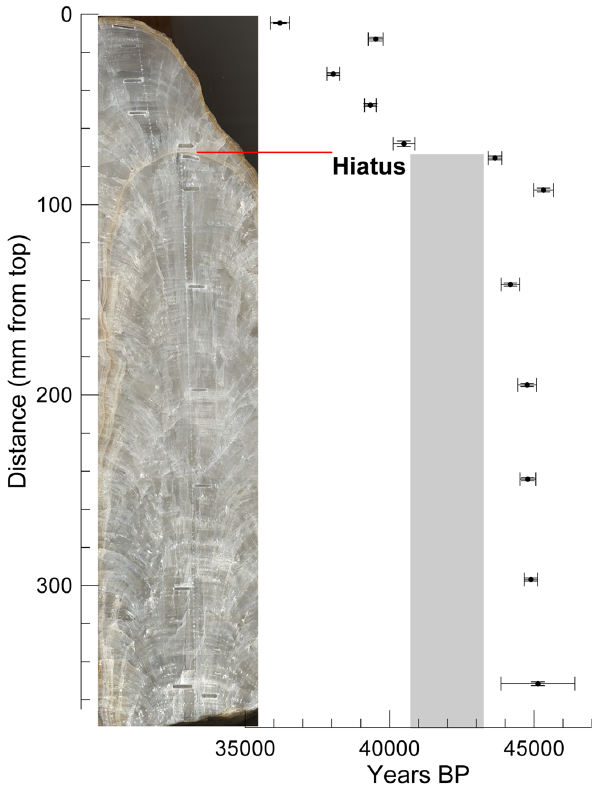
Fig. 5. Depth-age diagram of YOK-G: U-series dates included in this example are shown as red dots. Two different layer counts (vio- let and red lines) are available for the interval between 30 to 55mm from top (see zoomed